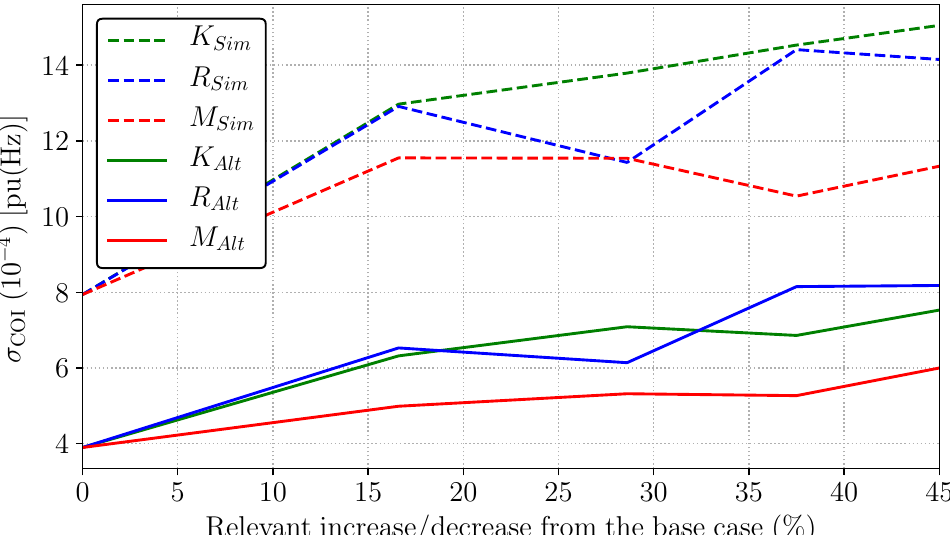
Figure 5. 15-min time period— σ COI as a function of different frequency controllers/machine parameters using the simplified and alternative SUC models.